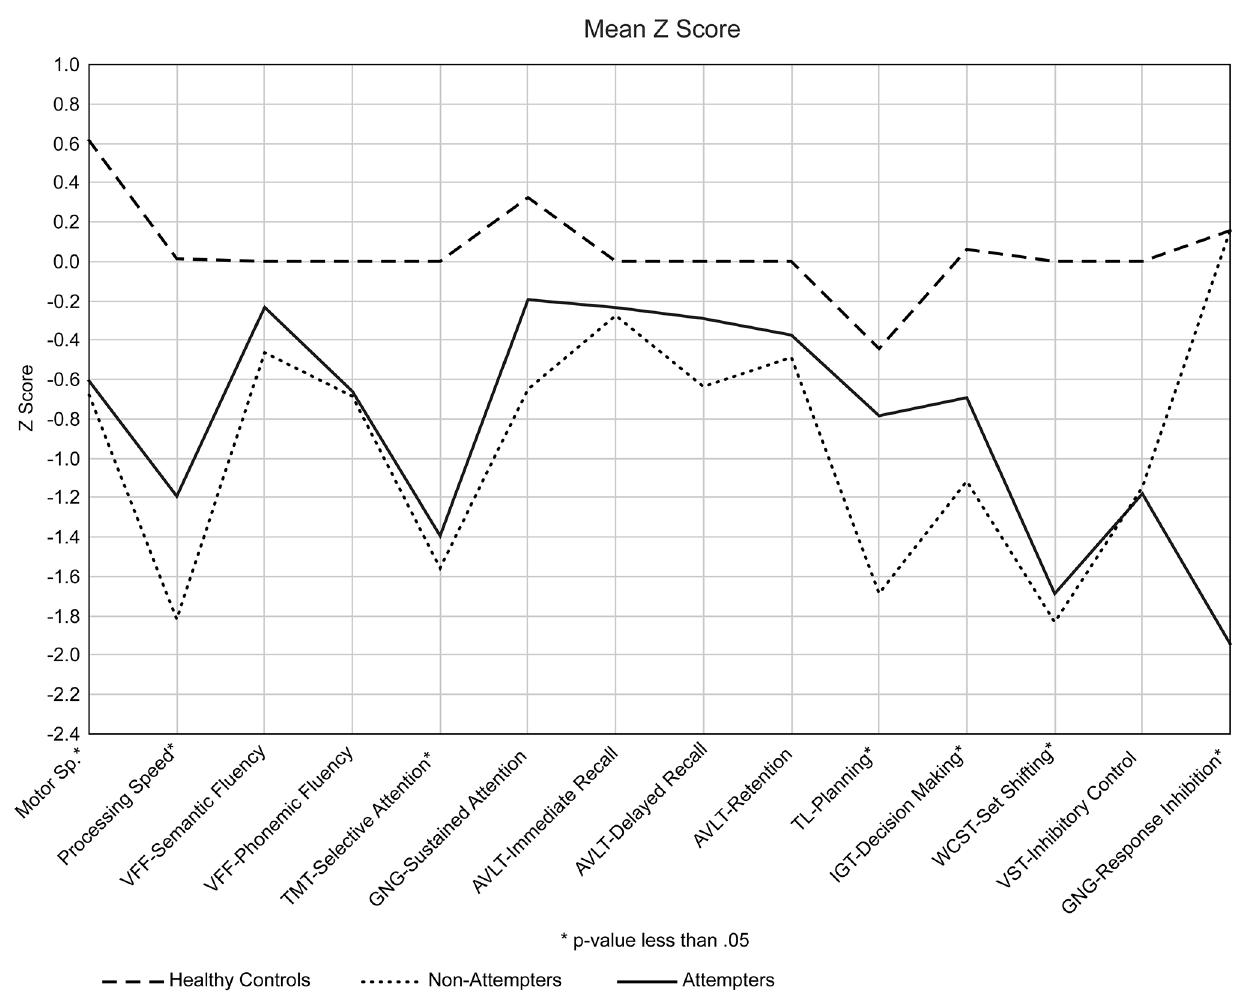
Figure 1. Z scores of the neuropsychological tests presented by each cognitive